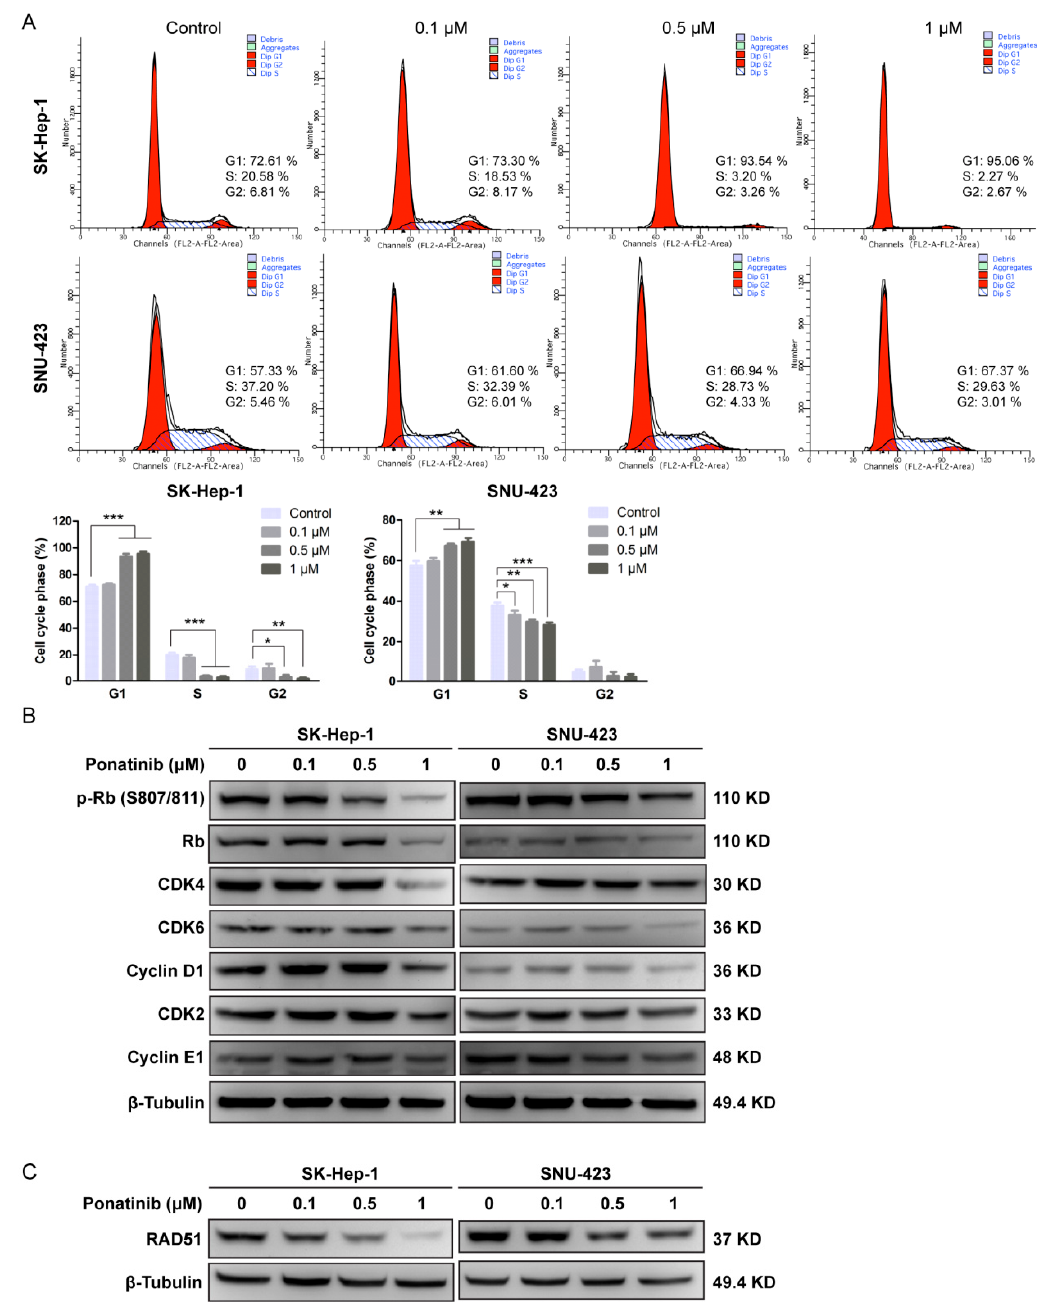
Figure 3. Effect of Ponatinib on the percentage of cells in the G1 phase and the expression of G1 phase-related proteins. ( A ) SK-Hep-1 and SNU-423 cells were treated with ponatinib, and cell cycle distribution was analyzed by flow cytometry. The percentages of cells in cell cycle phases were calculated from three independent experiments. ( B ) Western blot analysis of Rb/p-Rb, CDK4, CDK6, Cyclin D1, CDK2, Cyclin E1, and β -Tubulin (control) in the SK-Hep-1 and SNU-423 cells treated with ponatinib. ( C ) The effect of ponatinib on the concentration of Rad51 in SK-Hep-1 and SNU-423